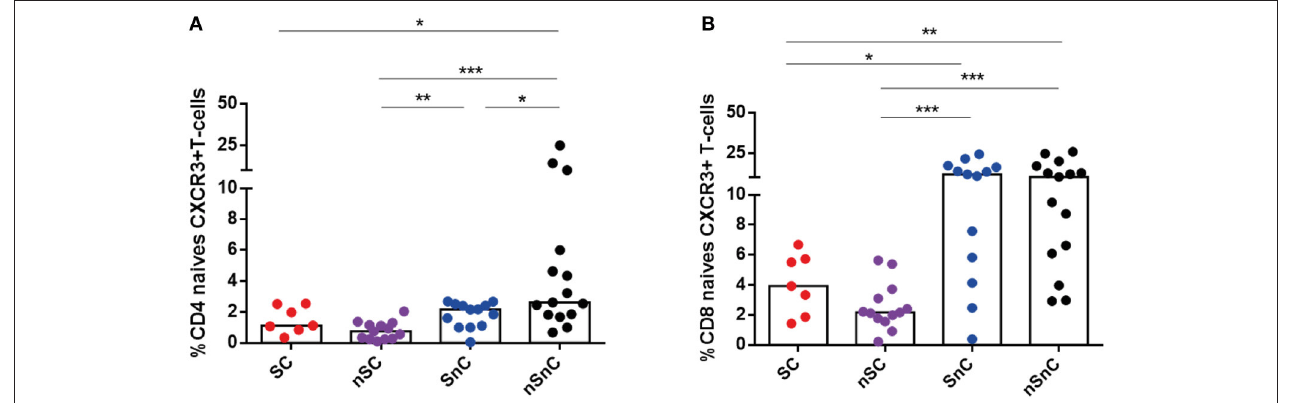
FIGURE 4 | CXCR3 expression in naive CD4 and CD8 T-cells. (A) Frequency of naive CD4 CXCR3 + T-cells. (B) Frequency of naive CD8 CXCR3 + T-cells. One outlyer SC and one nSC were excluded. SC, supercontrollers, HCV spontaneous clearers and HIV-elite controllers; nSC, non-spontaneously HCV clearers HIV-elite controllers; SnC, HCV spontaneous clearers non-HIV-elite controllers; nSnC, non-spontaneously HCV clearers non-HIV-elite controllers. Mann–Whitney U -tests was used to assess diferencies between groups. Statistical values are shown as: * p = 0.05–0.01; ** p = 0.01–0.001; *** p < 0.001.